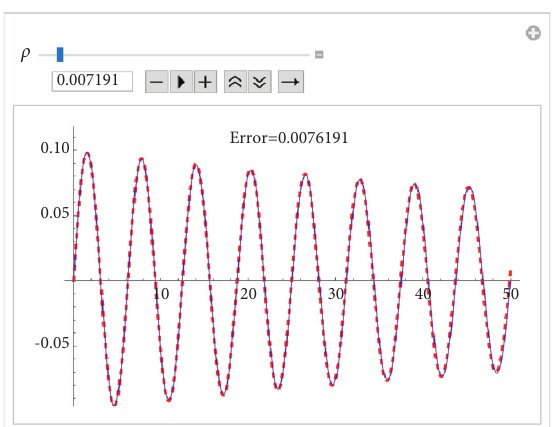
Figure 1: Comparison between the analytical approximant (44) (formula (8)) and the Runge–Kutta numerical solution for the i.v.p (43).